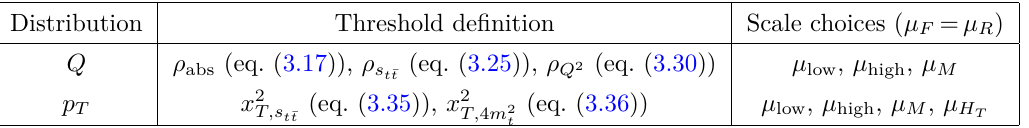
Table 1 . Summary of threshold definitions and scale